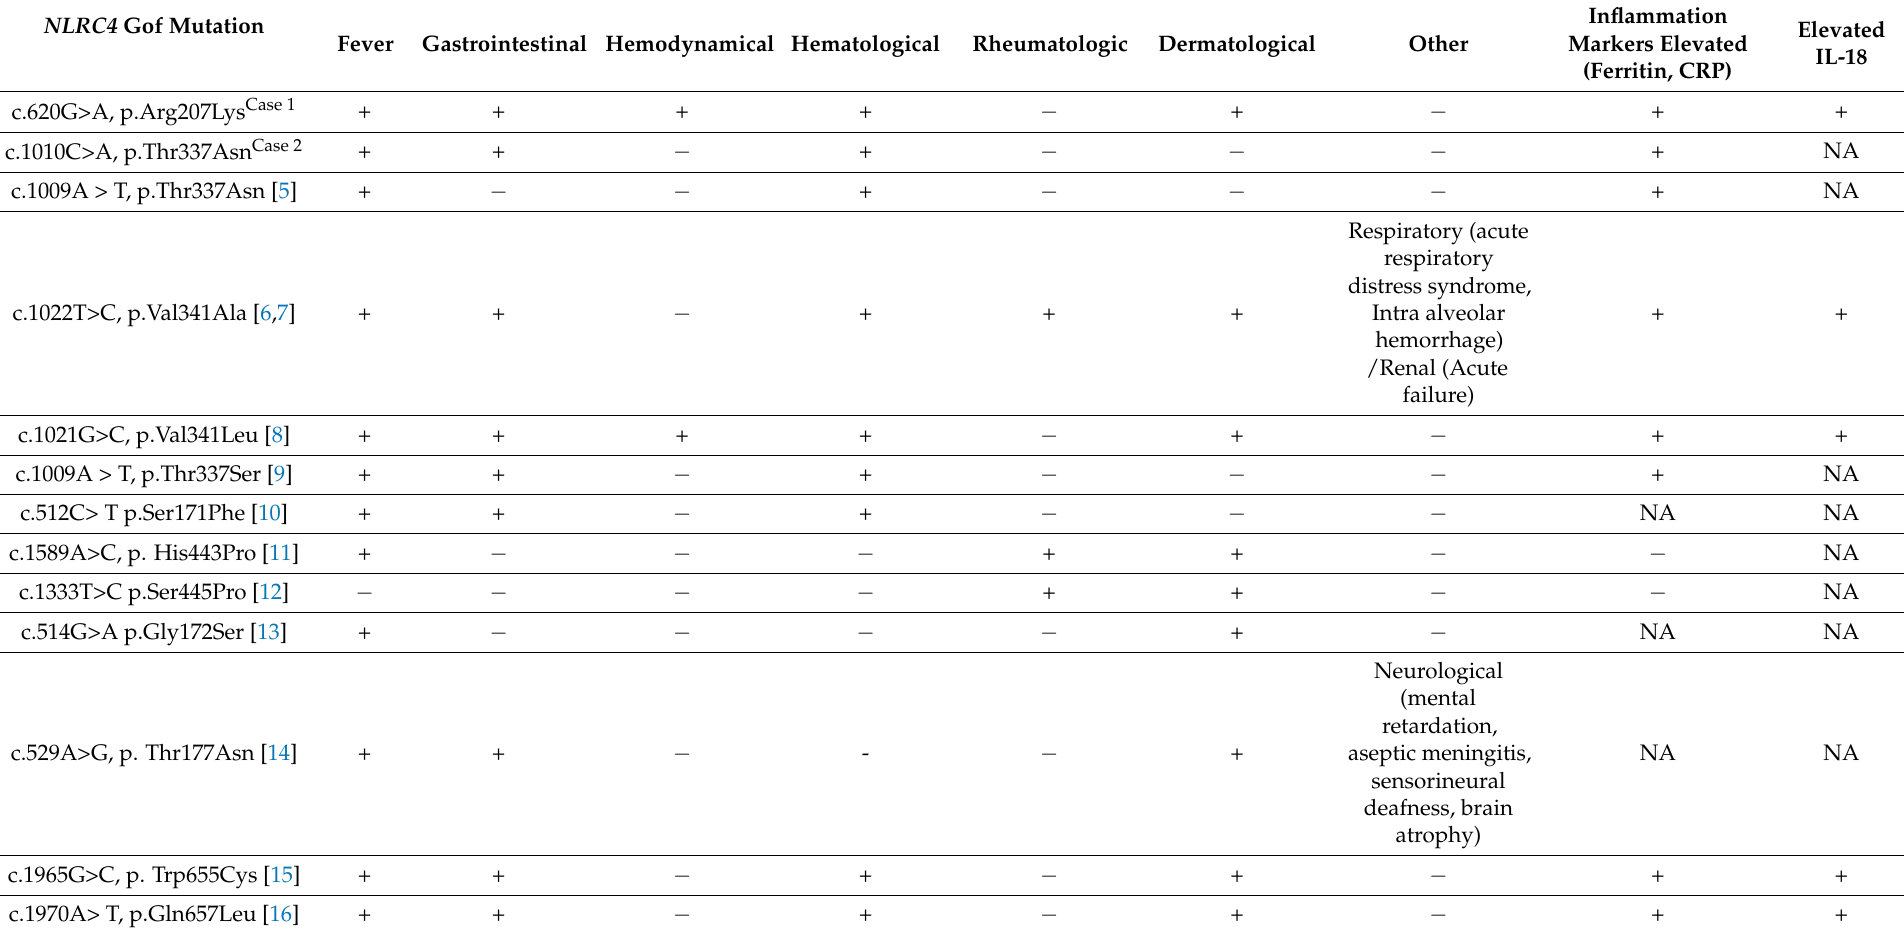
Table 1. Phenotype of patients according to NLRC4